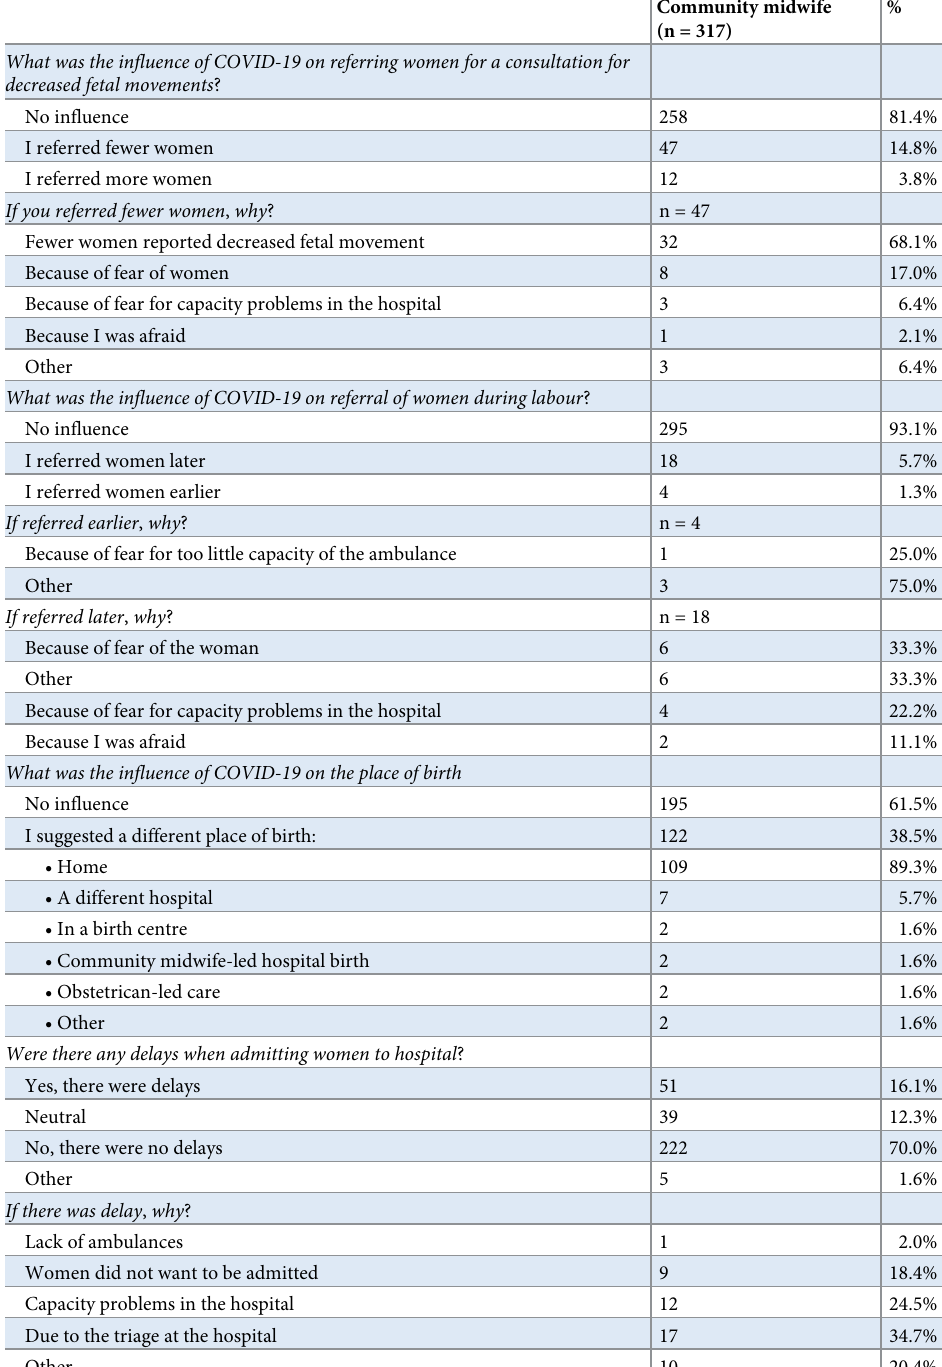
Table 5. Care management by community